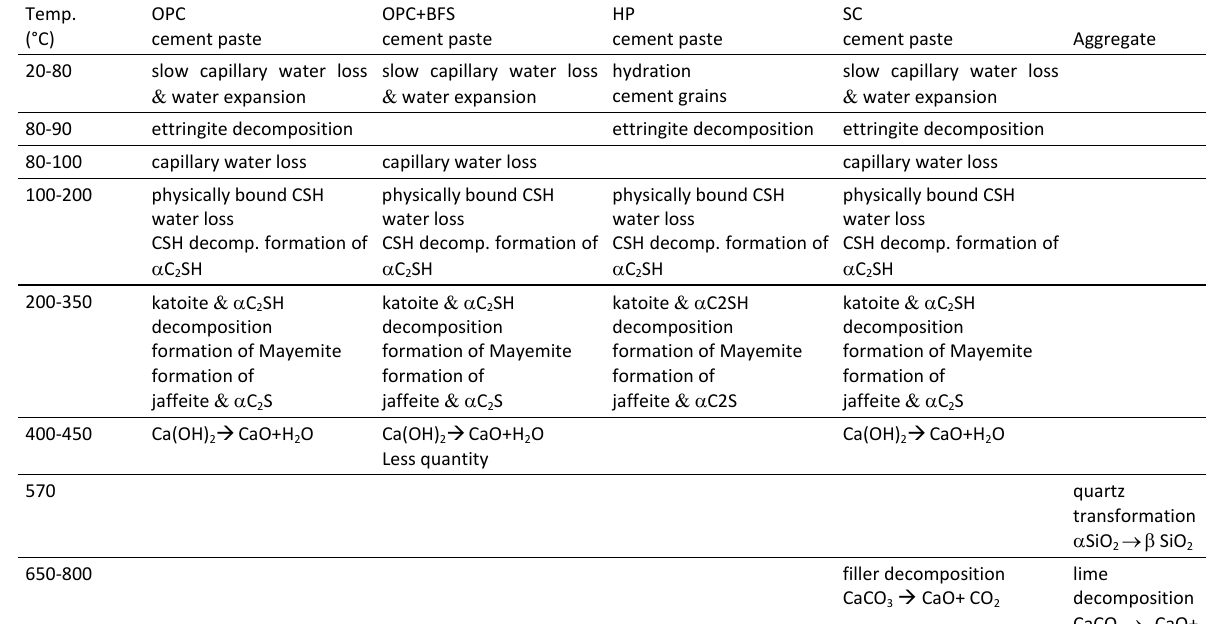
Table 1. Transformation and decomposition reactions at high temperature in the main components of concrete  4 ‐ 8  . Temp. (°C)